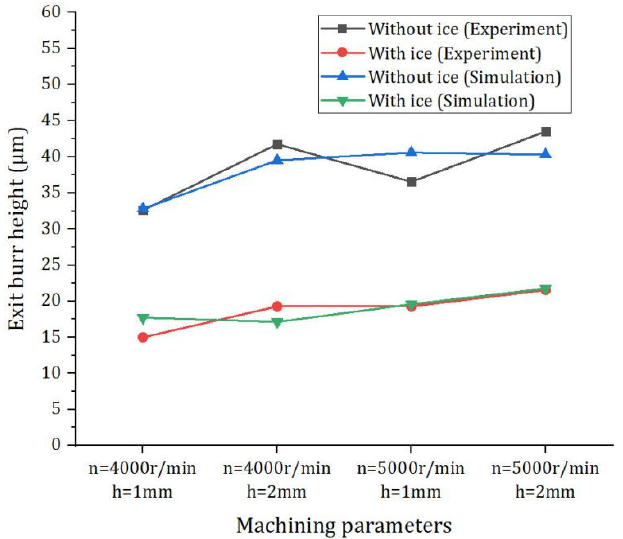
Figure 11. Comparison of simulation results with experimental results.